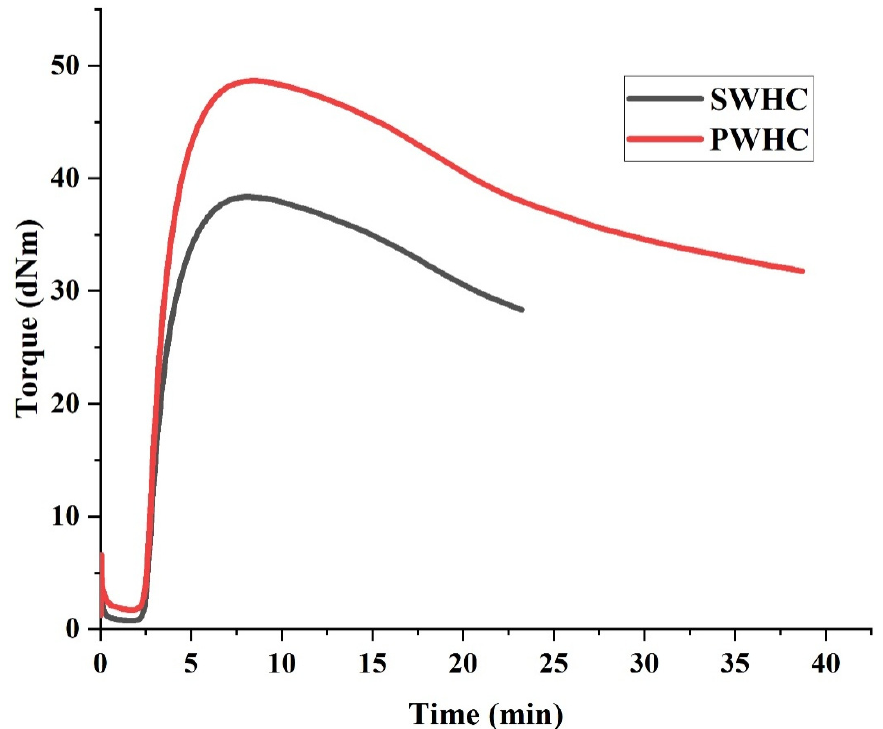
Figure 1. Cure characteristics of the SWHC and PWHC.